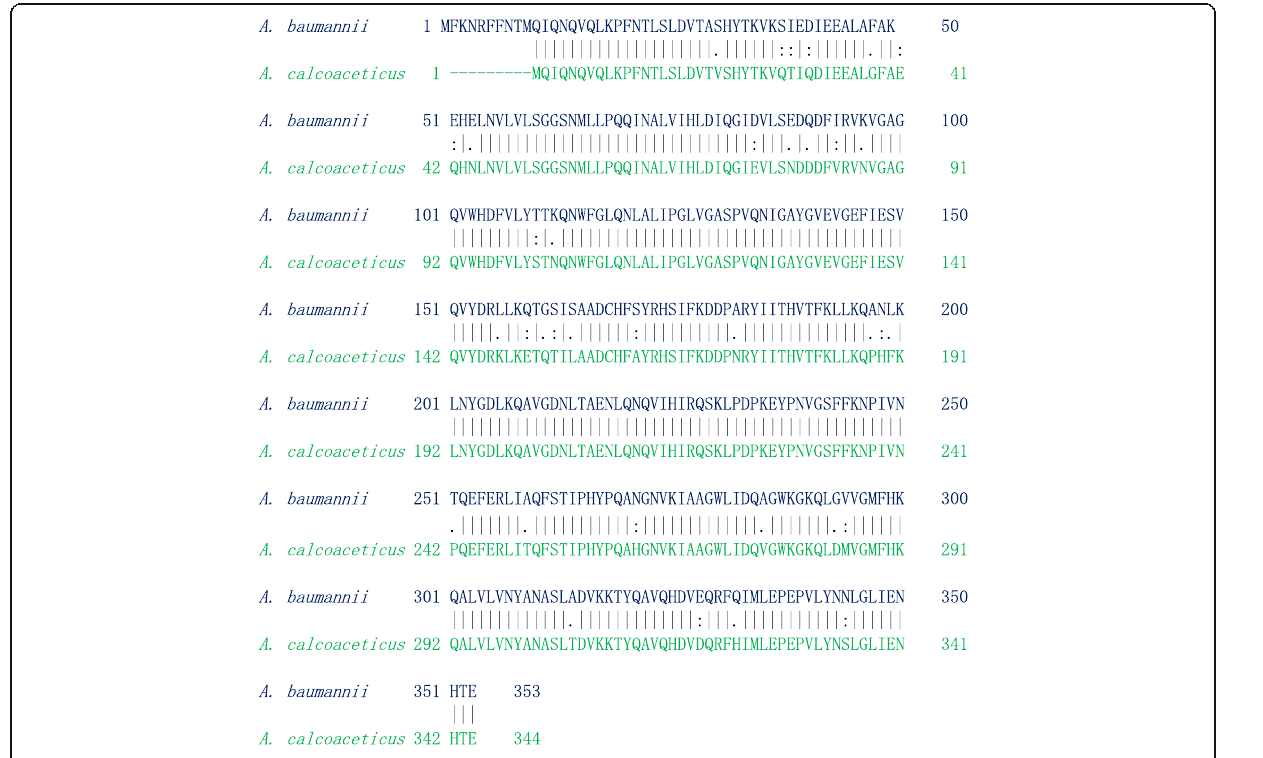
Fig. 5 Pairwise sequence alignment of MurB protein from A . baumannii and MurB from A . calcoaceticus